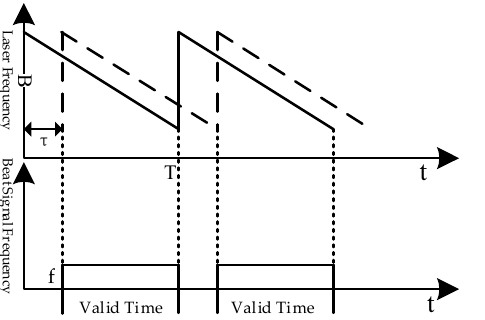
Figure 1. The ranging principle diagram of frequency modulation continuous wave (FMCW)